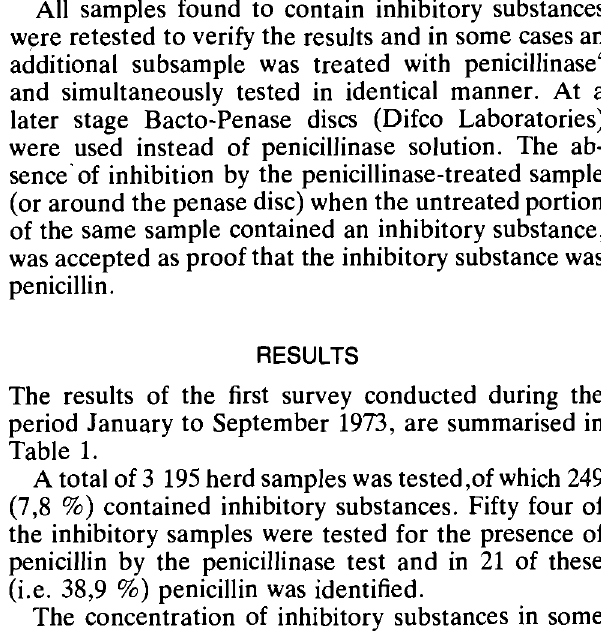
Table 2: THE INCIDENCE OF INHIBITORY SUBSTANCES IN PASTEURIZED MILK SOLD IN PRETORIA DURING THE PERIOD JANUARY 1973 TO JUNE 1976.